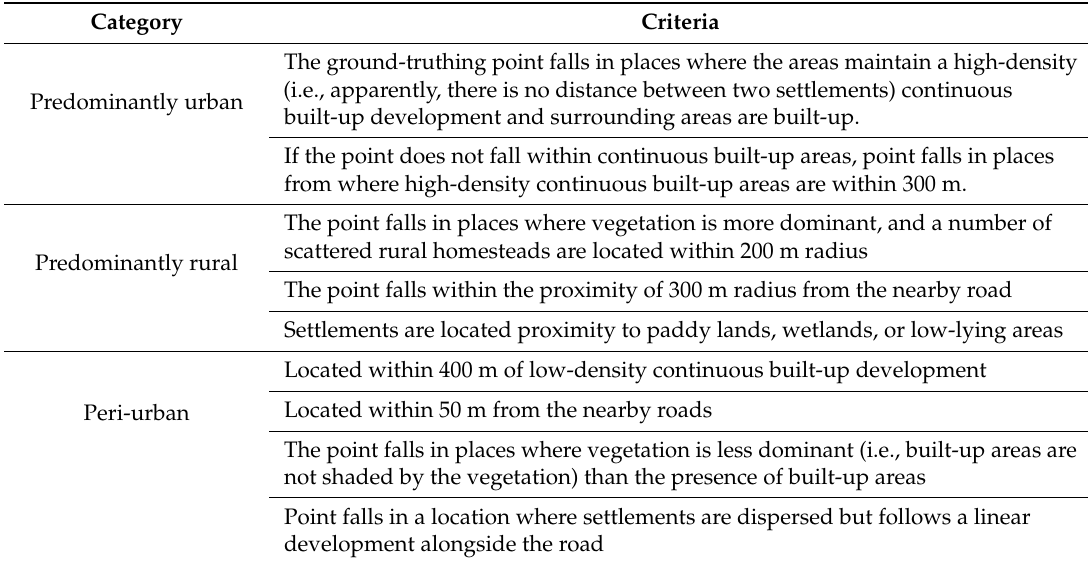
Table 3. Criteria to ground-truth the NTL VIIRS data mapping of 2016. Category